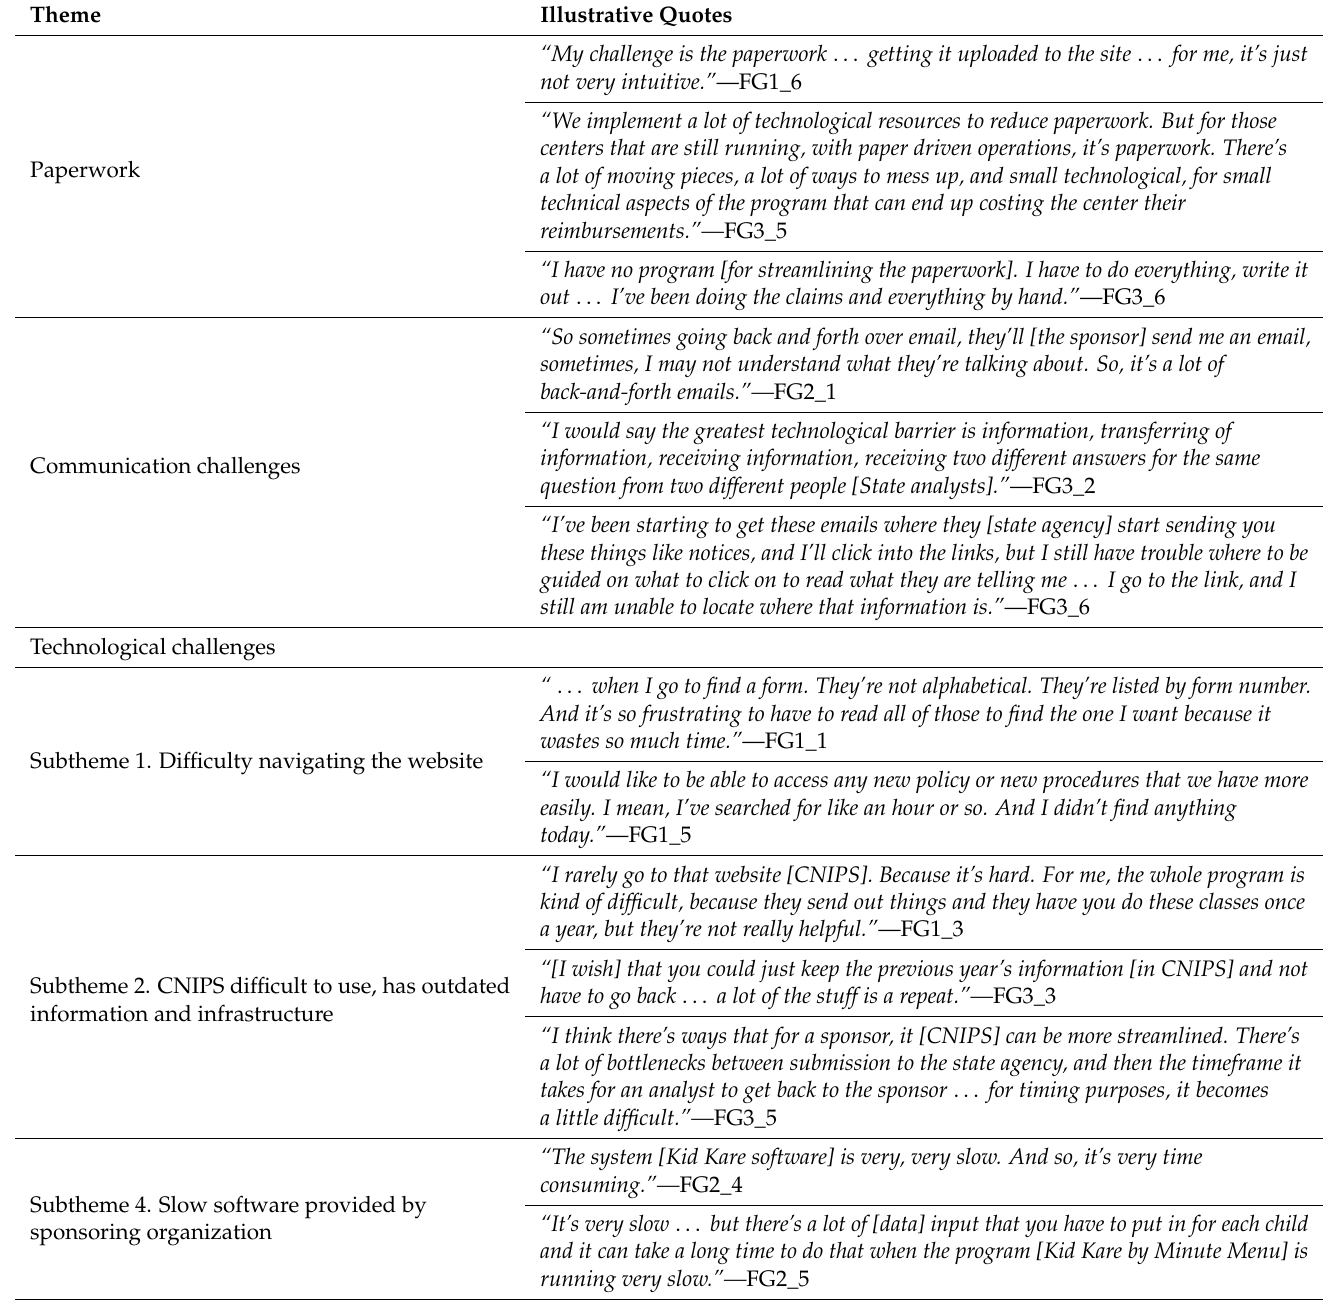
Table 5. Emergent themes of barriers to participating in the CACFP 1